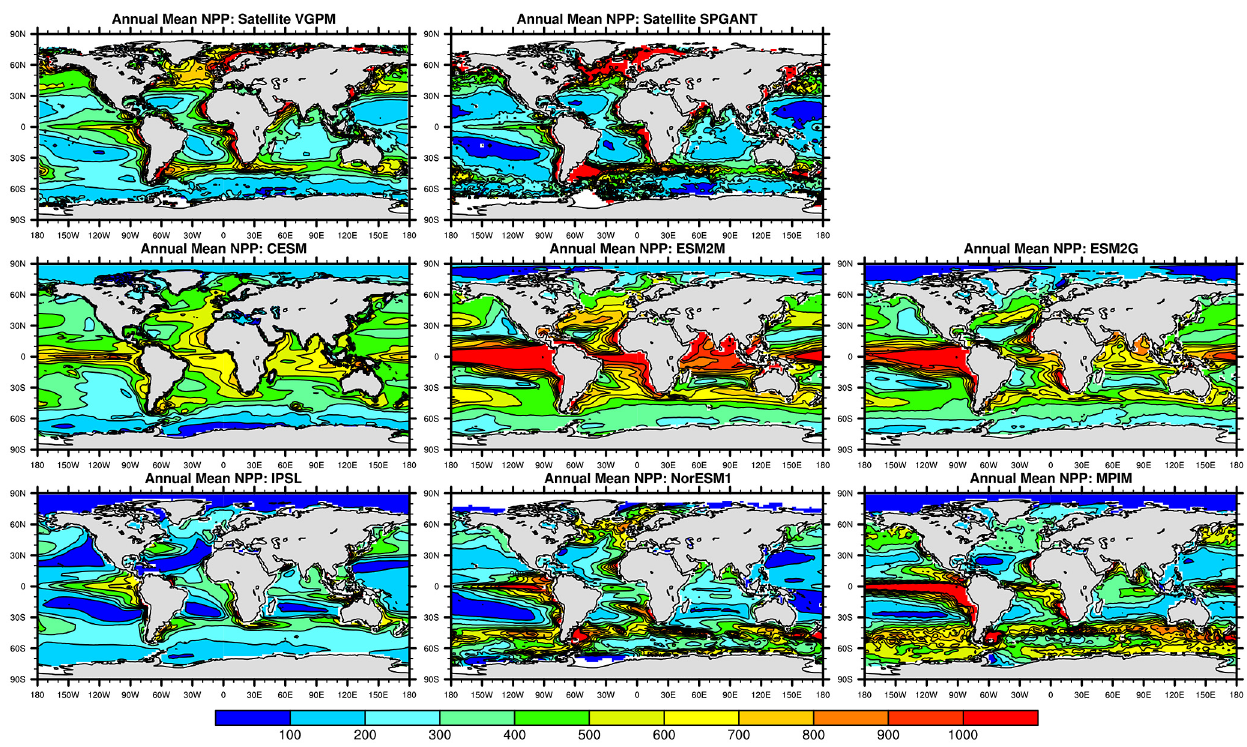
Figure 5. Annual mean NPP (in mgCm − 2 day − 1 ) . Top row: MODIS-Aqua data input to the VGPM NPP model and (b) SeaWiFS data input to the SPGANT algorithm as described in Nevison et al. (2012a). Rows 2 and 3 show the corresponding NPP fields from six ESMs for the mean of 1997–2005.